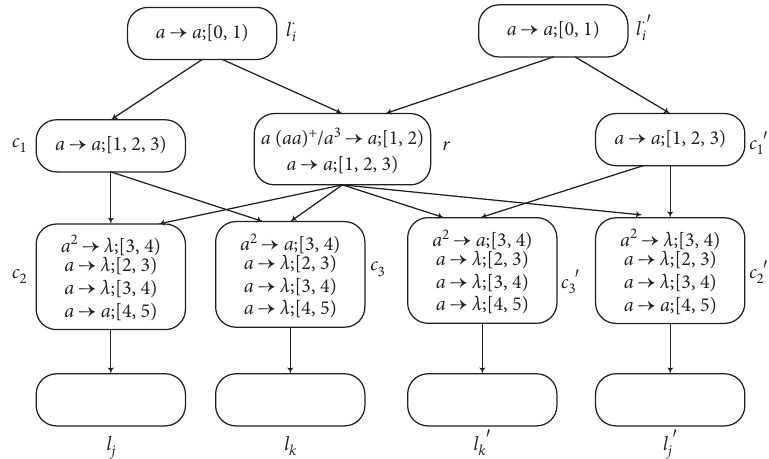
Figure 4: Module SUB-SUB: simulating the SUB instructions l